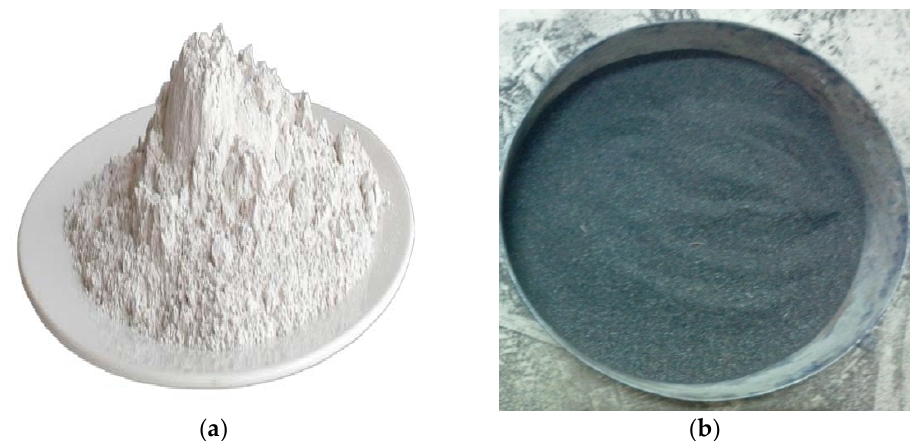
Figure 1. ( a ) Ground granulated blast furnace slag; ( b ) corn cob ash.